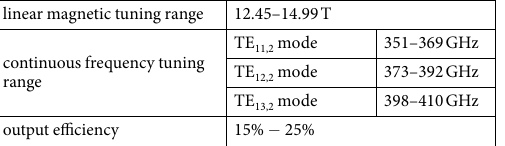
Table 3. Tuning parameters and output parameters in mode